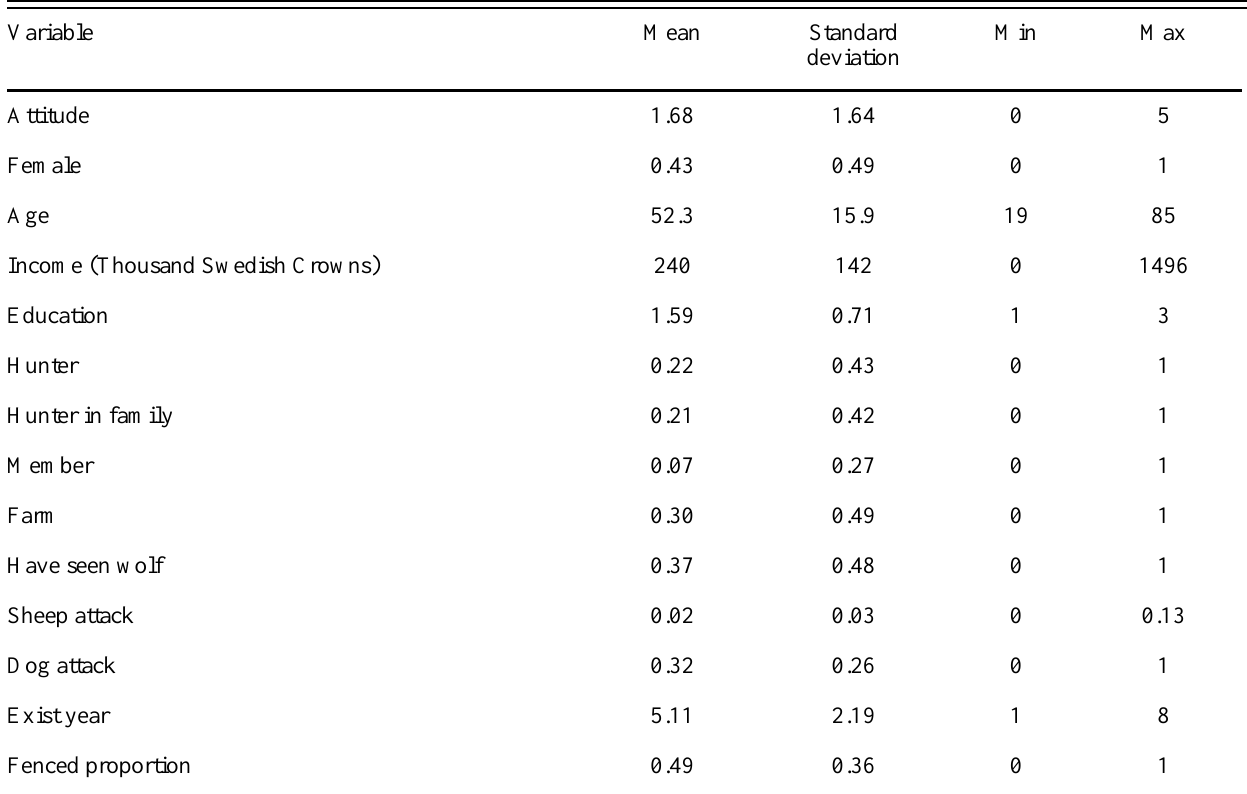
Table 2. Descriptive statistics of the variables used. Variable Mean Standard